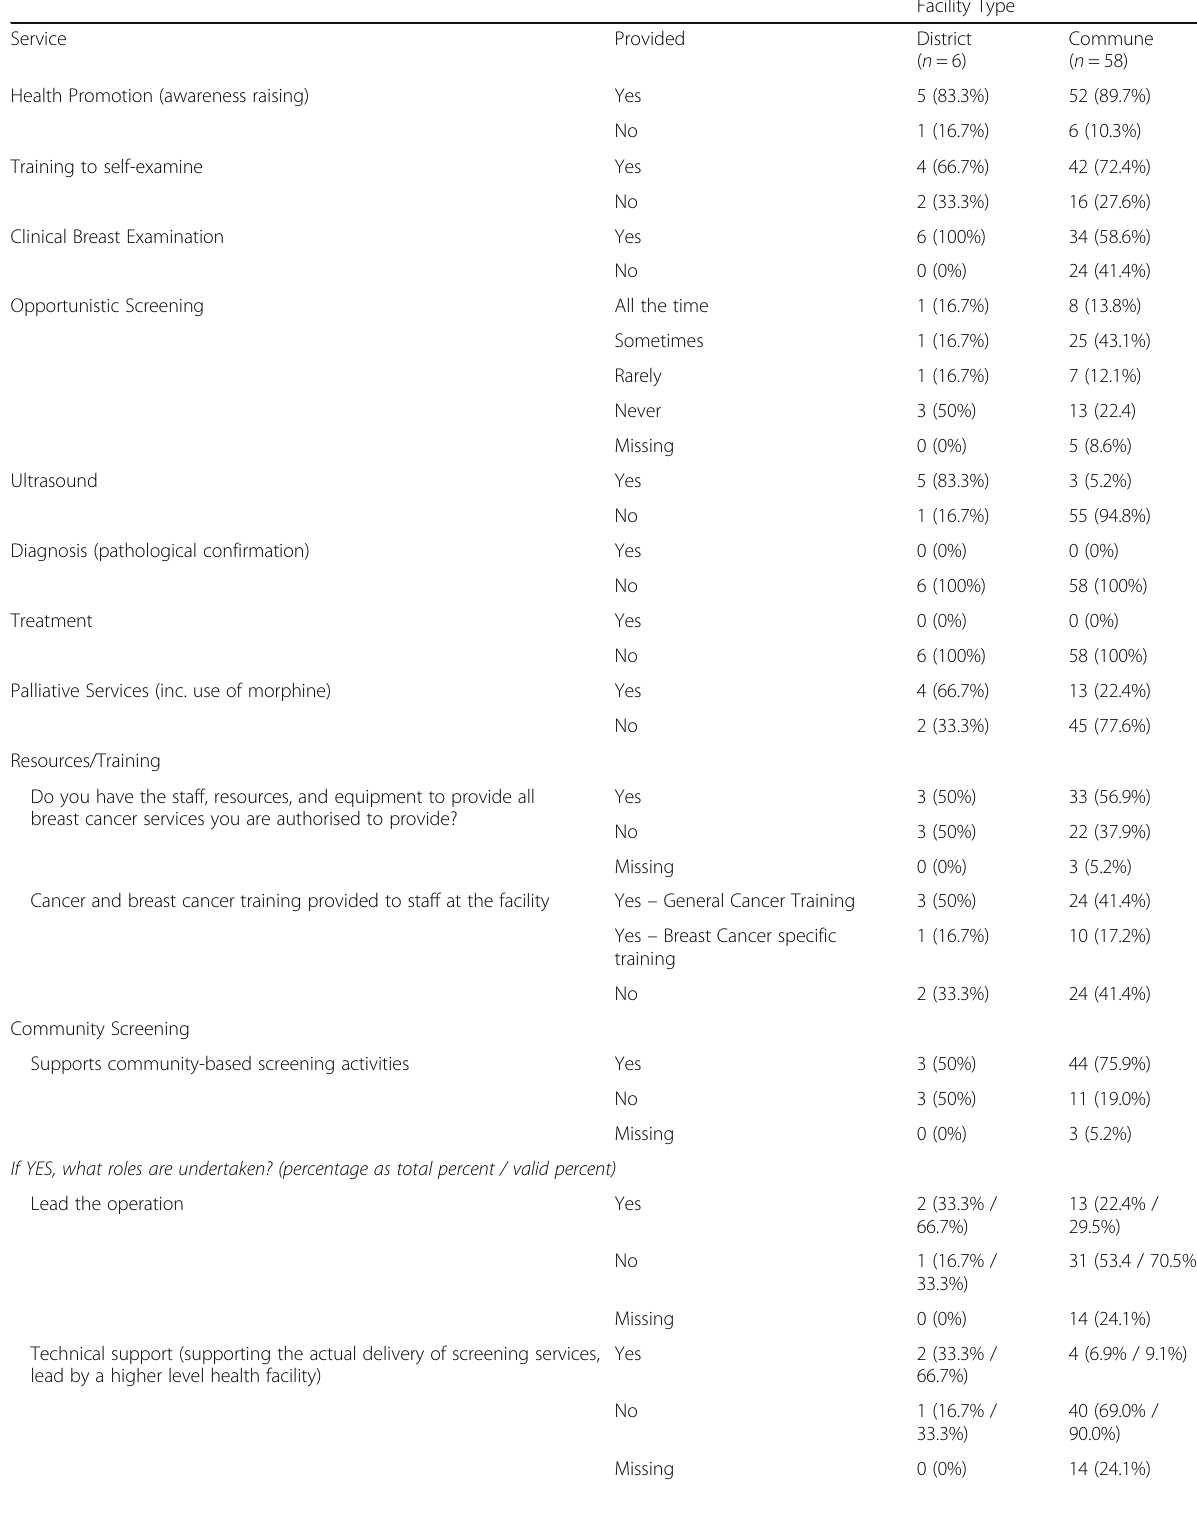
Table 4 Overview of results from